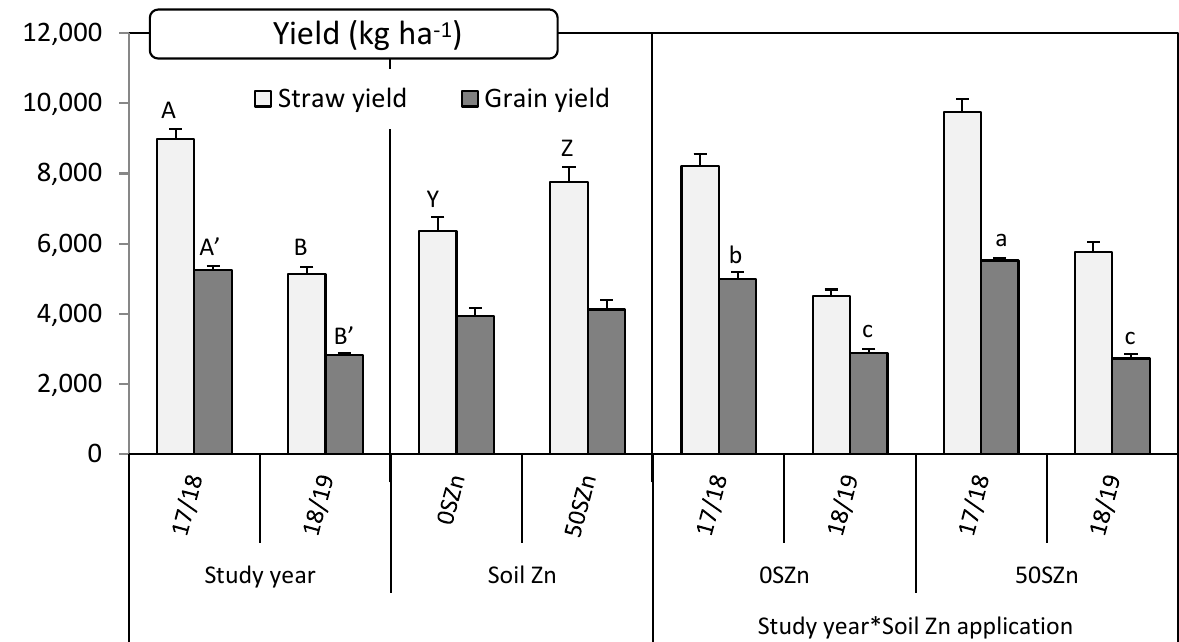
Figure 4. Influence of the main effects ‘Study year (Y)’, ‘Soil Zn application (S)’ and their interaction ‘Y*S’ on both straw and grain yield. Charts indicate means ( n = 4) and error bars indicate standard error. Within each parameter and factor, different letters mean significant differences between means according to LSD test ( p ≤ 0.05). To make the differences clearer, a different set of letters was assigned to each factor (lowercase letters (a, b, c) for the interaction, uppercase letters [A, B] for ‘Y’ and uppercase letters (Z, Y) for ‘S’. Letters follow by apostrophe (‘) for grain.